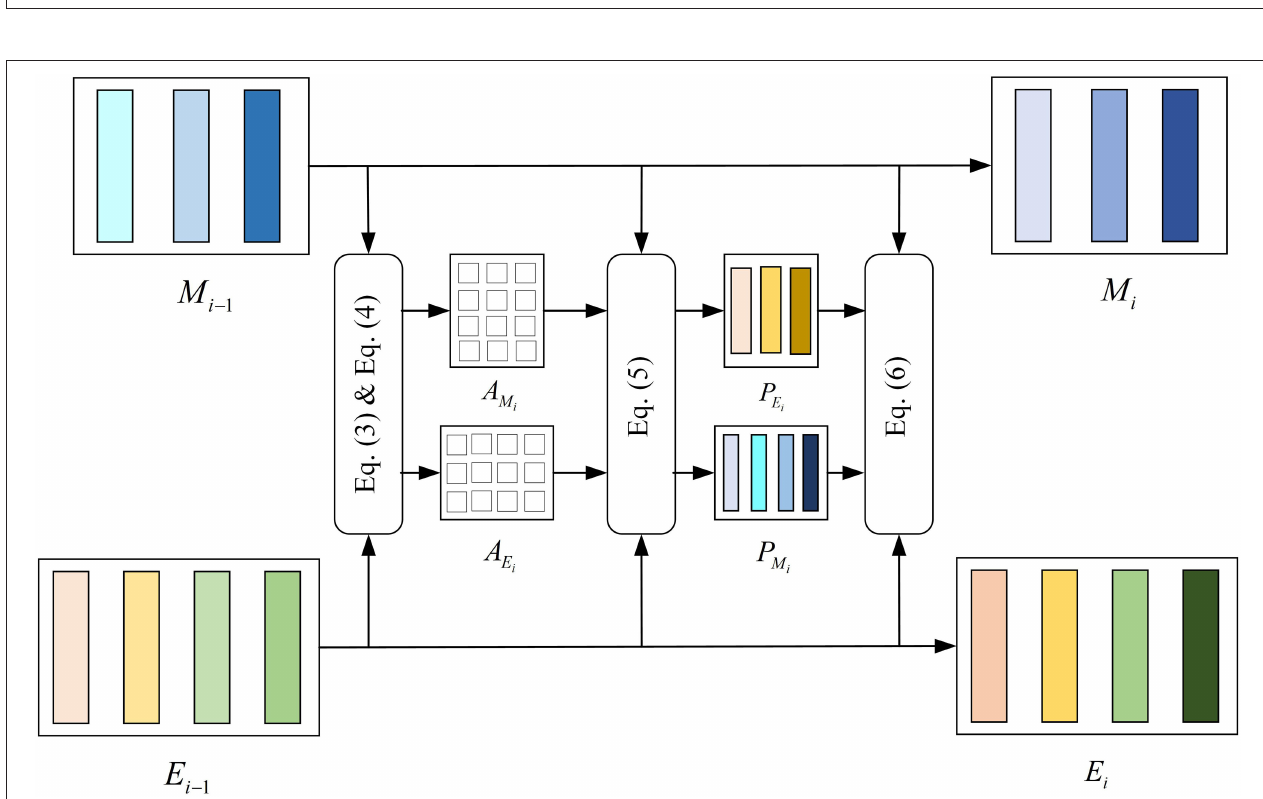
FIGURE 1 | The overall architecture of the DMEFNet model. This model contains two feature extraction modules, a feature fusion module, and a lower limb movement prediction module. The feature extraction module uses EEGNet and MCSNet to extract the features of EEG signals and sEMG signals, respectively. The feature fusion module enhances the co-attention between sEMG and EEG signal features through the DCA mechanism.